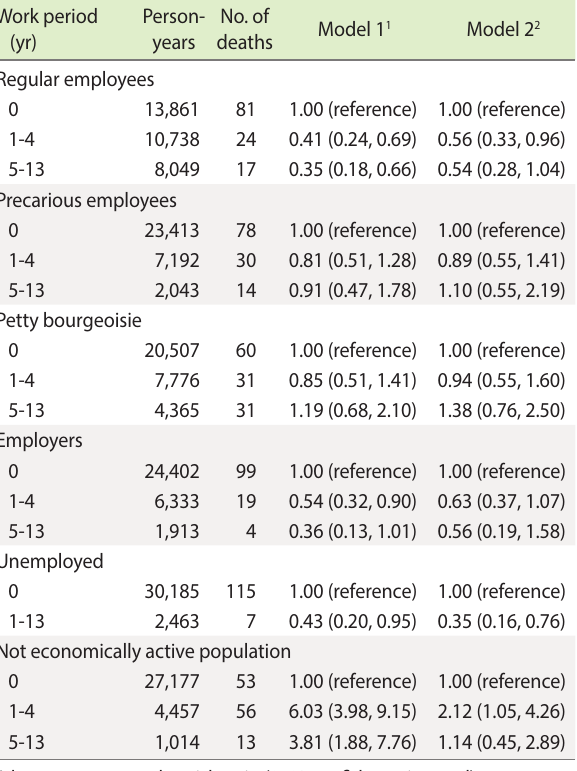
Values are presented as risk ratio (95% confidence interval). 1 Adjusted for age and other employment